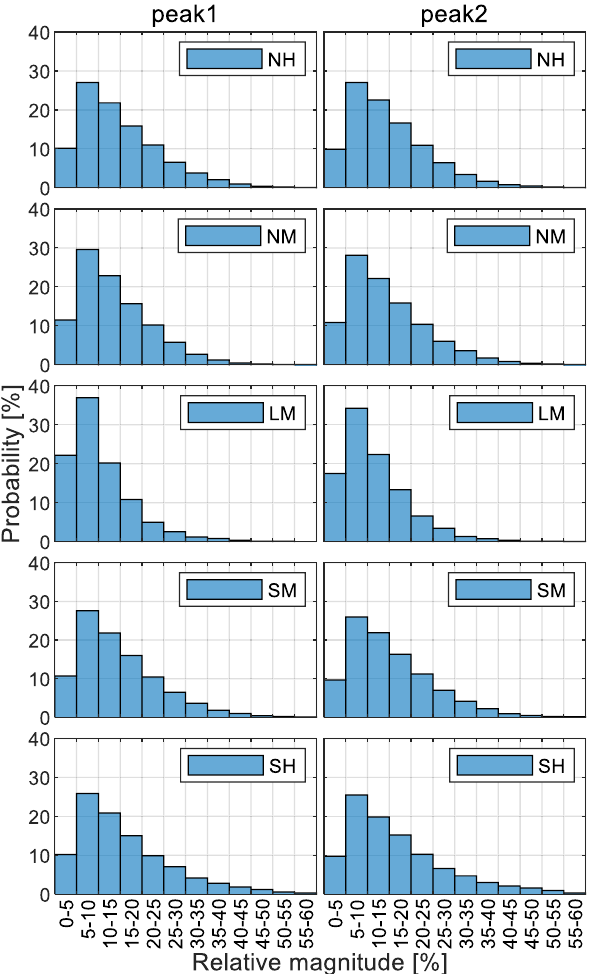
Figure 12. The probability distribution of the relative magnitude of the two peaks in different MLAT regions.